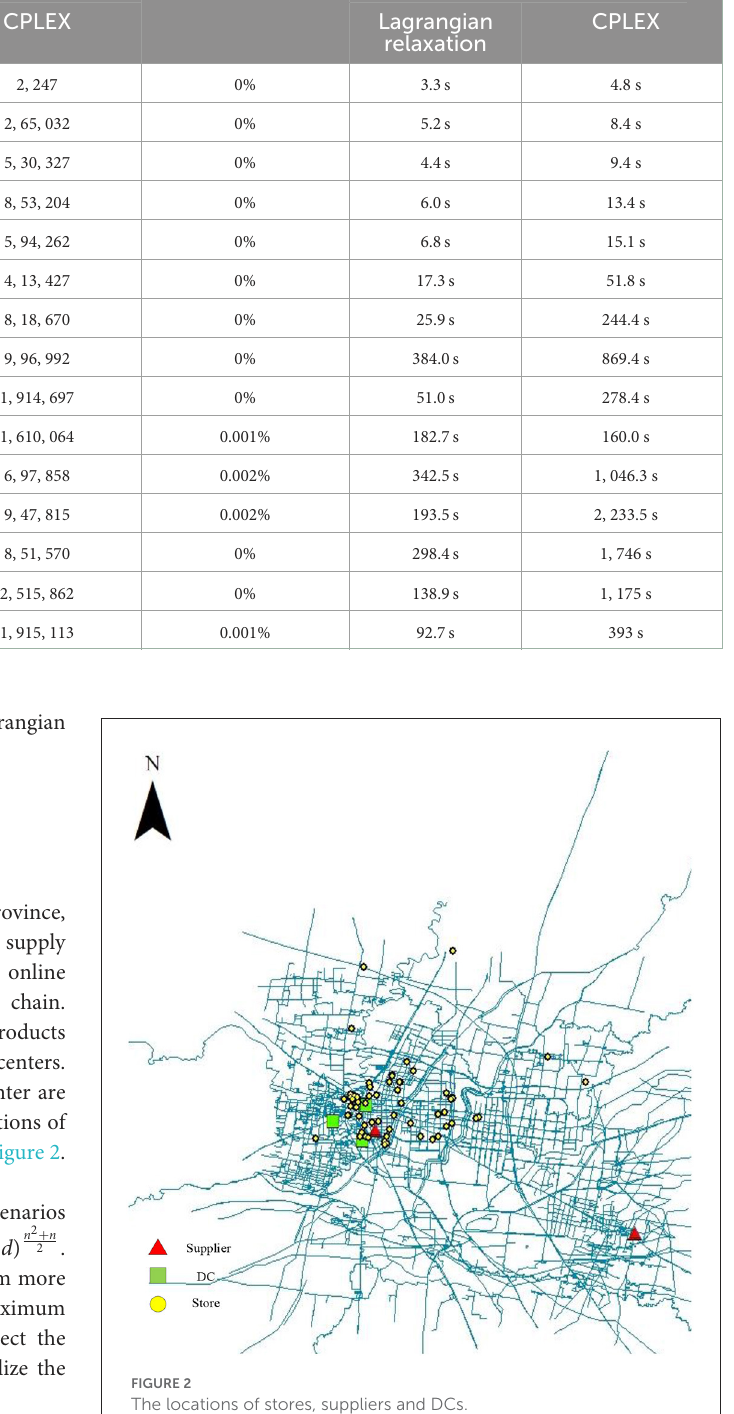
TABLE 3 The performance comparison of the results. Set Objective Gap Objective Lagrangian CPLEX Lagrangian relaxation